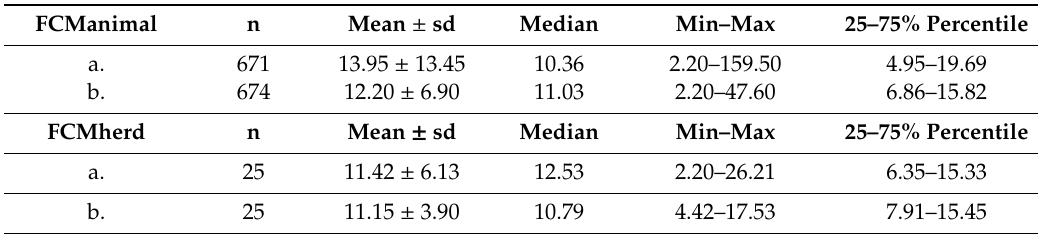
Table 2. Fecal cortisol metabolite (FCM) concentrations (ng / g) at individual animal level (FCManimal) and at herd level (FCMherd), a. values of the first sampling (when cows’ behaviors were also recorded), b. medians of all (3–4) samplings.